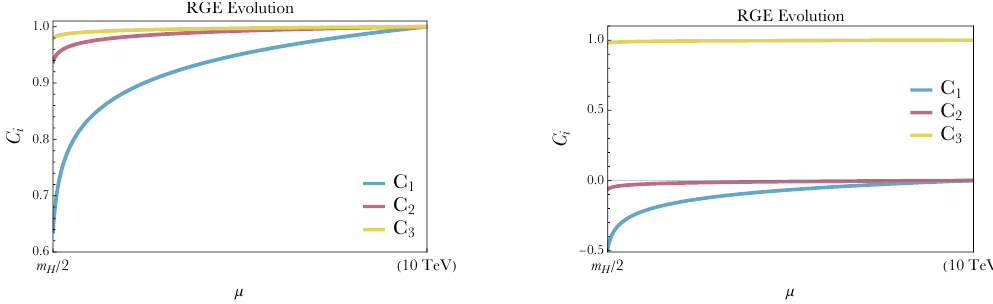
Figure 2 . Renormalization group evolution of the three Wilson coe(cid:14)cients between 10 TeV and m H = 2 in two scenarios. Left: C 1 = C 2 = C 3 = 1 at (cid:22) = 10 TeV. Right: C 1 = C 2 = 0 and C 3 = 1 at (cid:22) = 10